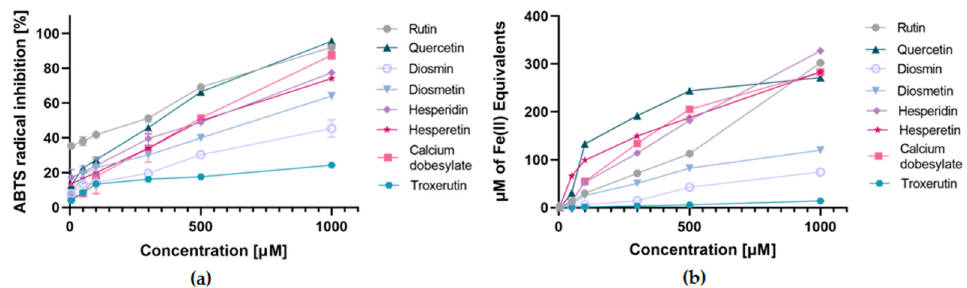
Figure 3. Concentration-dependent antioxidant activity of investigated vasoprotectives in ( a ) ABTS assay expressed as percent of radical inhibition; ( b ) FRAP assay expressed as Fe 2+ iron ion equivalent (Fe(II) µ M); all measurements were performed in triplicate in the concentration range of 5–1000 µ M of tested compounds; results are presented as means ± SD ( n =